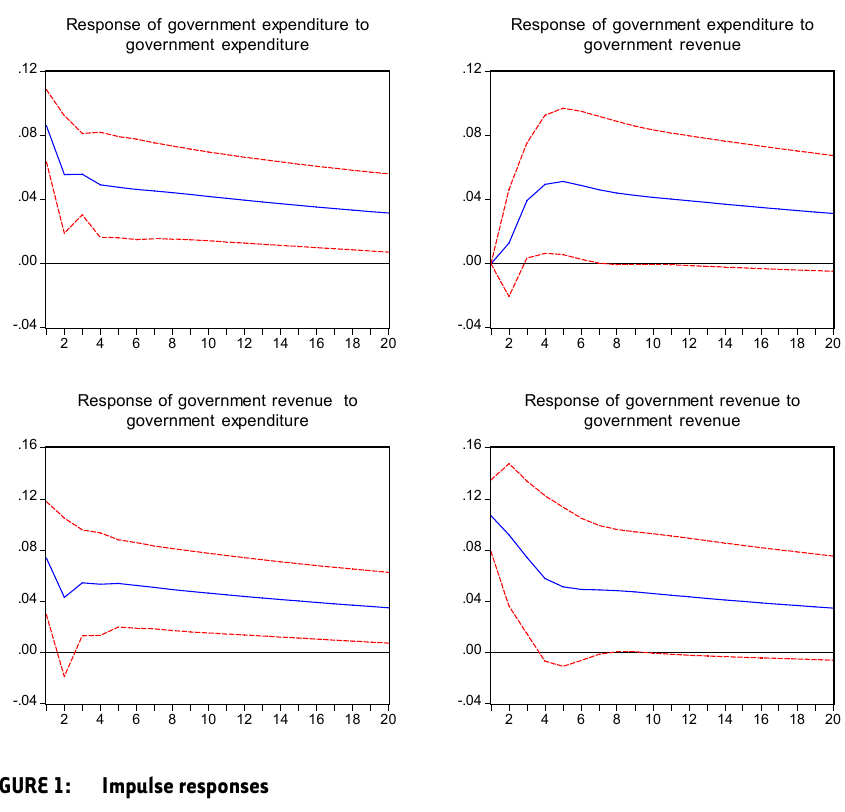
FIGURE 1: Impulse